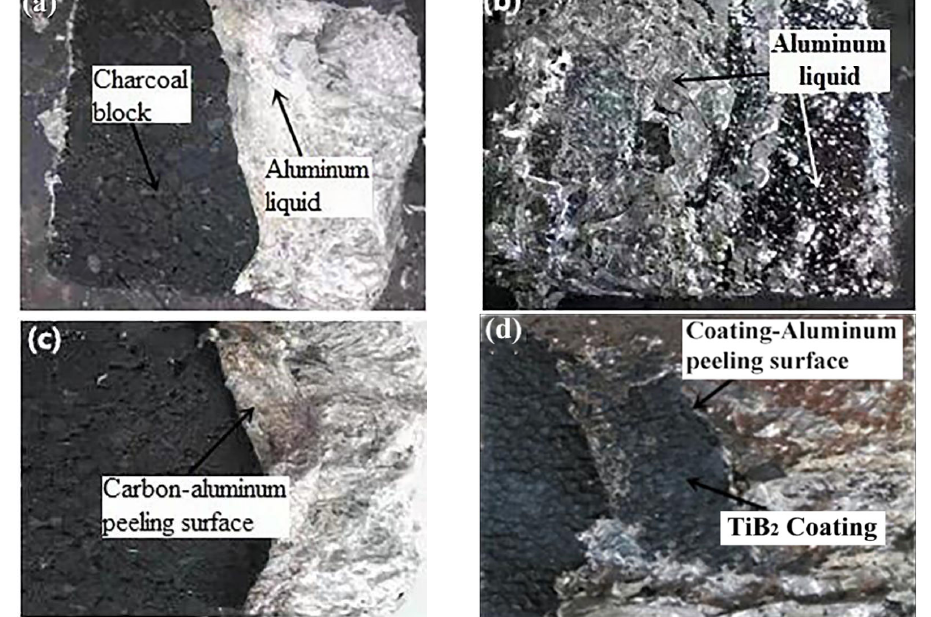
Figure 4. Characterization of wettability of TiB 2 coating prepared using cathode carbon block and plasma spraying to liquid aluminum. ( a ) SEM image wetting effect diagram of cathode carbon block